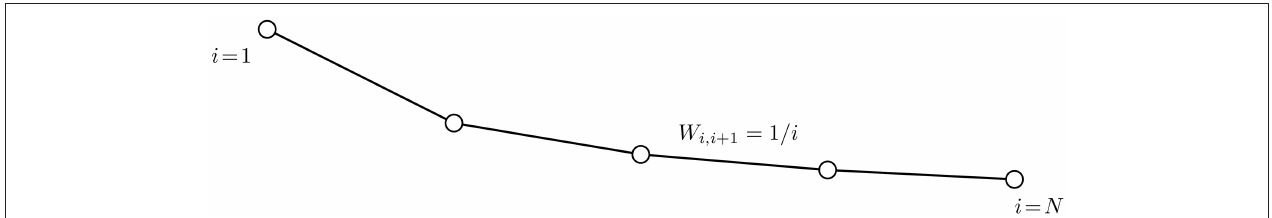
FIGURE 2 | The empirical graph G is a chain graph with edge weights W i , i x N 0 using Algorithm ˜ =